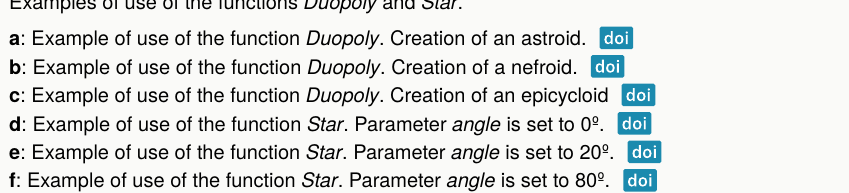
Examples of use of the functions Duopoly and Star